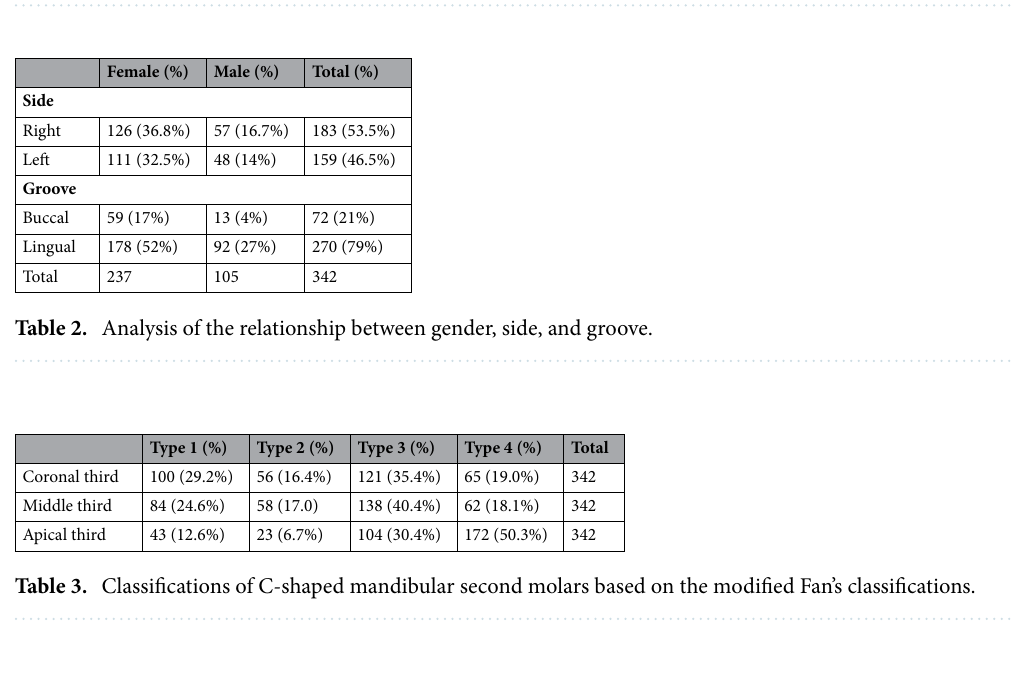
Table 1. Distribution analysis of gender, side, and groove distribution of C-shaped canals in mandibular molars of the Jordanian population.